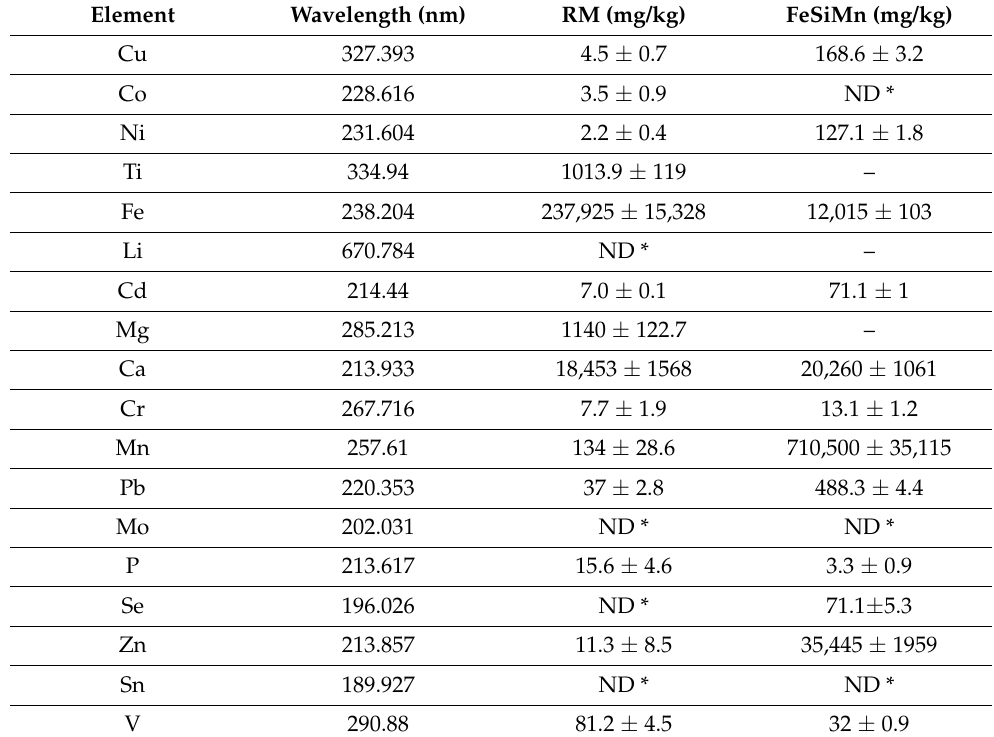
Table 3. Chemical composition of the red mud (RM) and the ferrosilicomanganese fine (FeSiMn) determined by ICP-OES.